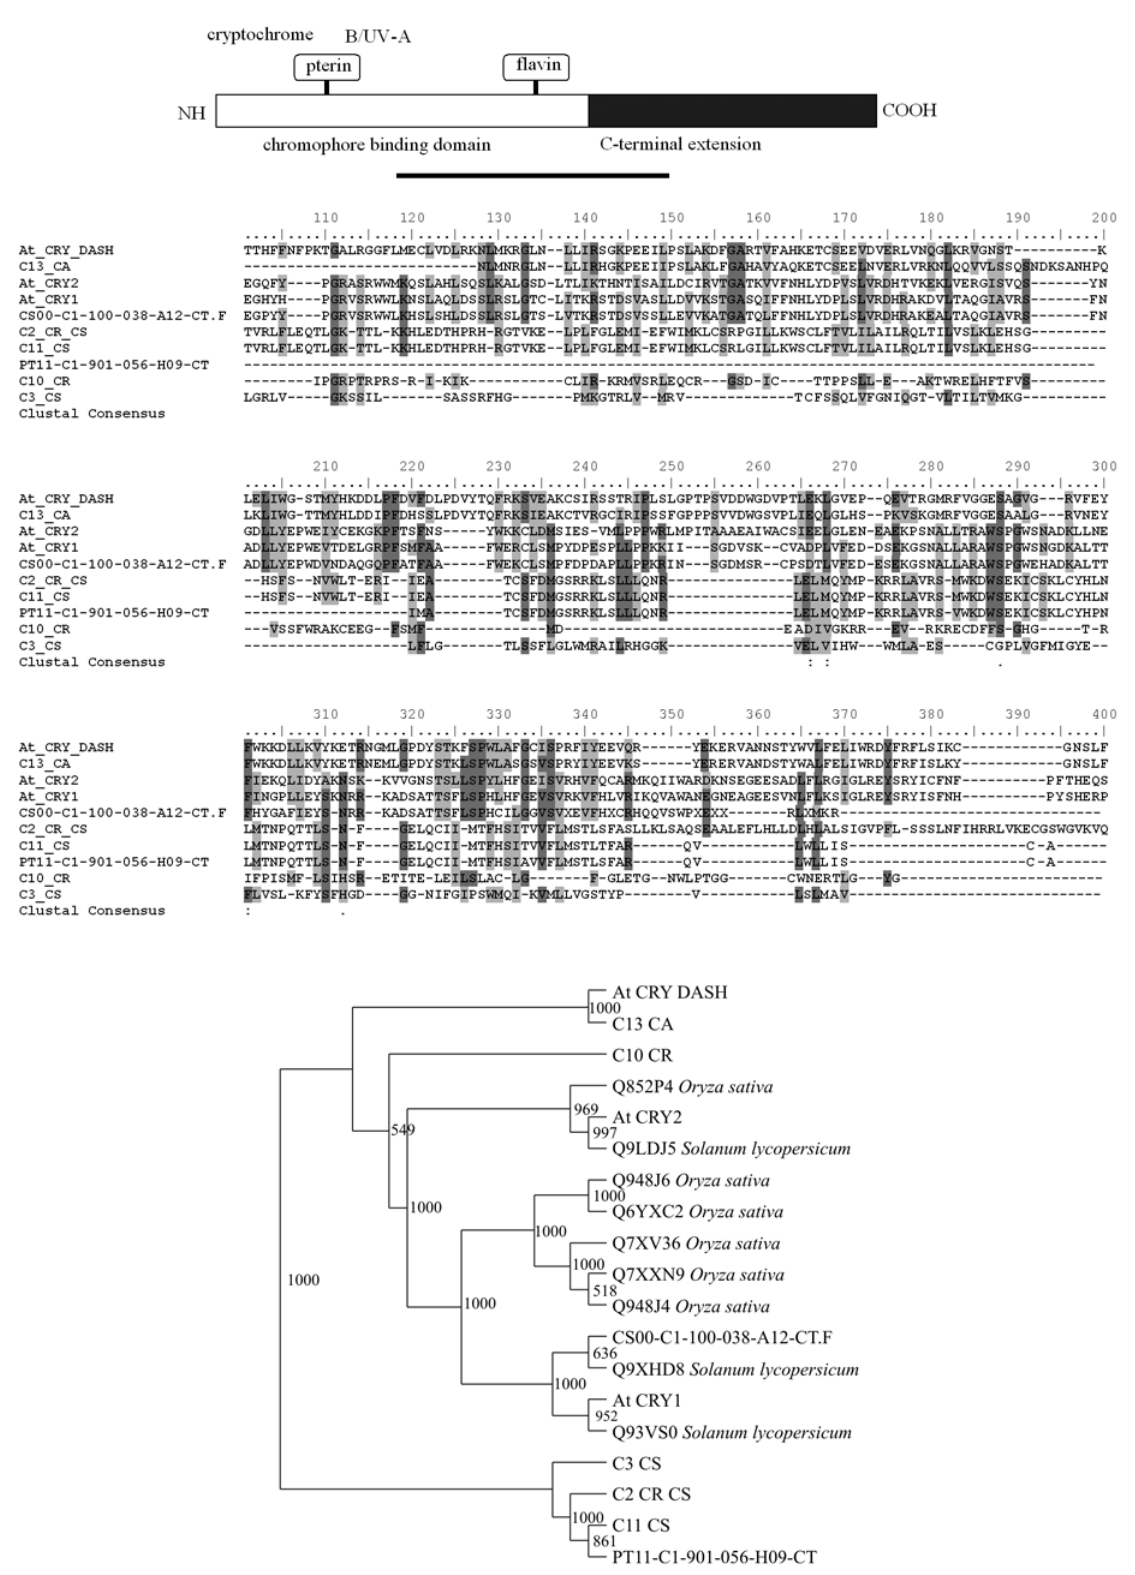
Figure 3 - Domain structure, phylogenetic analyses and alignment of the predicted amino acid sequence of the cryptochrome family in citrus. Neigh- bor-joining trees for citrus deduced amino acid and Arabidopsis full length sequences aligned with ClustalX are shown. Bootstrap values are indicated aboveeachbranch.Darkandlightgrayshadingindicatesequenceidentityandsimilarity,respectively.At, Arabidopsisthaliana ;B,bluelight;CNumber, contig number; CA, Citrus aurantium ; Cit, citrus; CS, Citrus sinensis ; CR, Citrus reticulata ; FAD, flavin adenosine